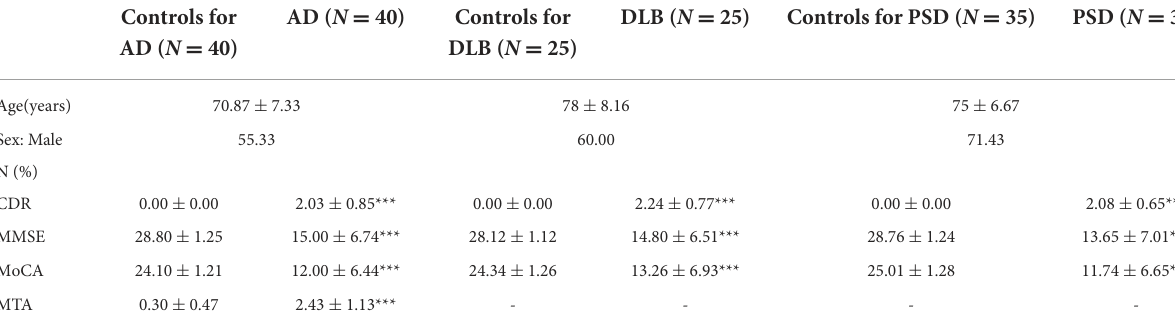
TABLE 2 Demographic and clinical characteristics of AD patients with age- and sex-matched